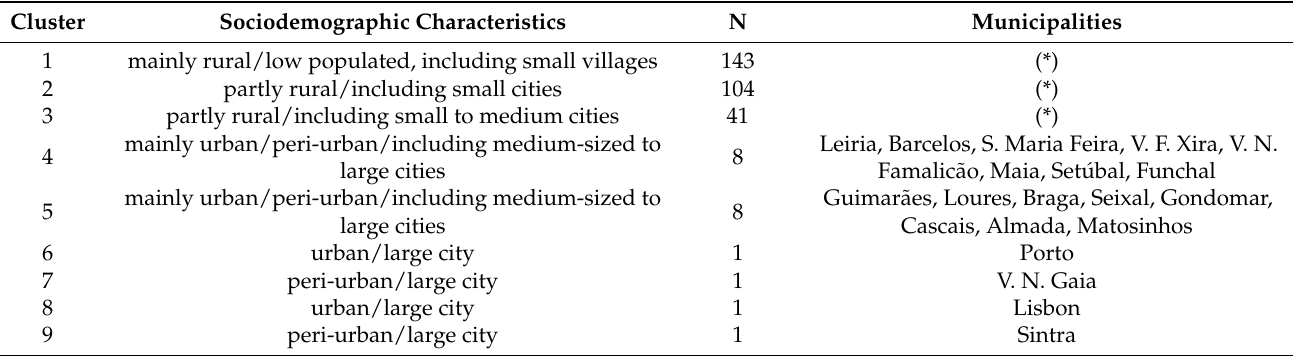
Table 1. Local Administrative Units 1 (municipalities) cluster distribution. Table reports the sociode- mographic and number of